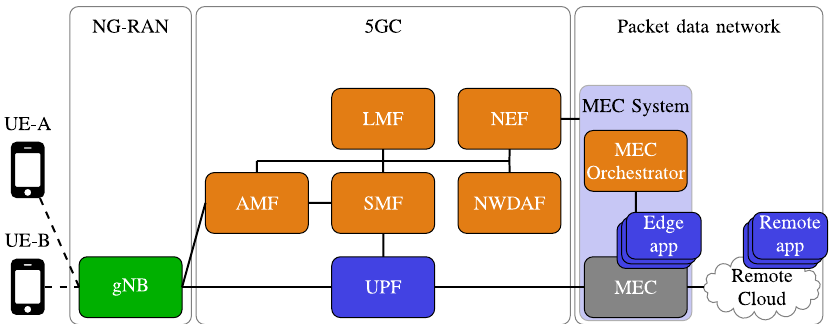
Figure 2. Simplified model of a 5G network with all functions related to localization. Radio access network elements, control-plane network functions, and user-plane network functions are shown in green, orange and blue, respectively. The computing platforms for OTT applications are shown in